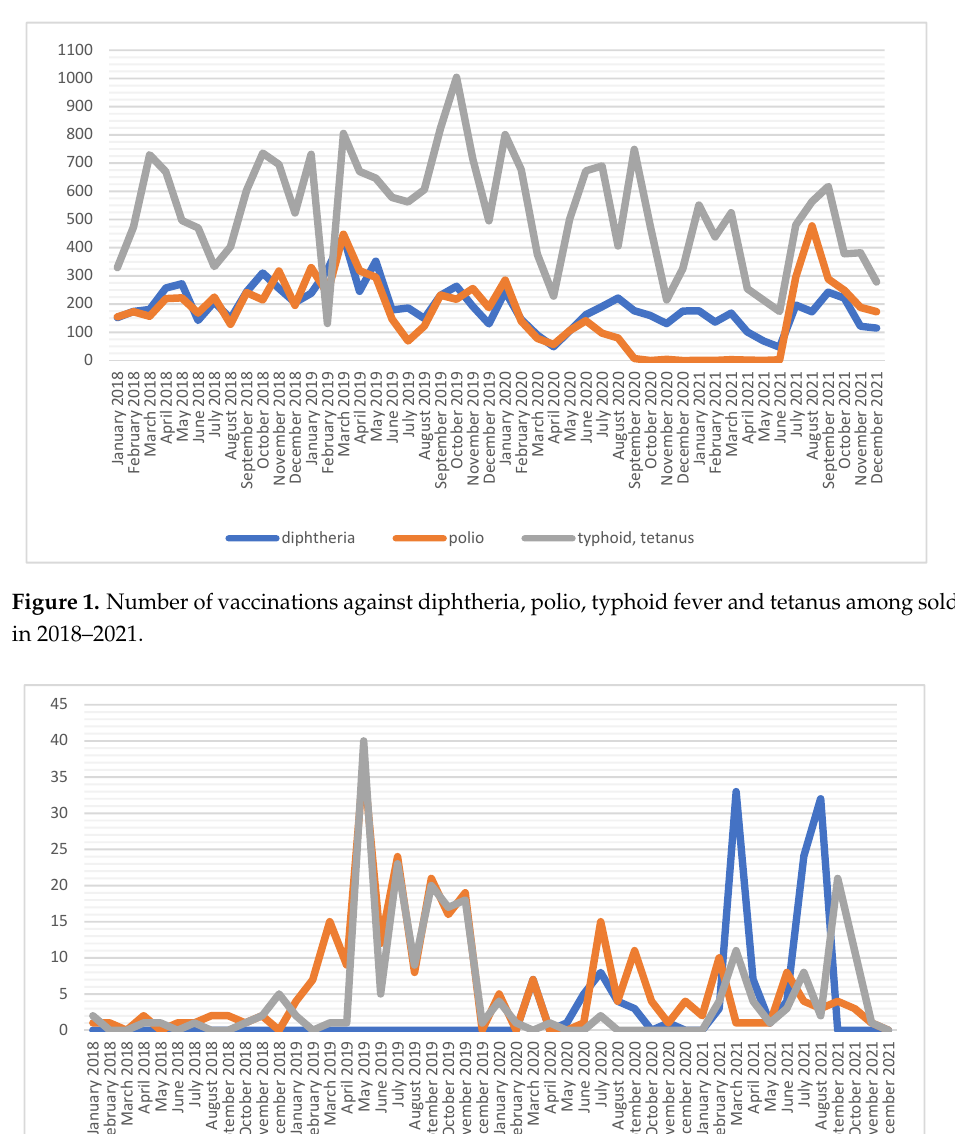
Figure 3. Number of vaccinations against measles, mumps, rubella and chickenpox among soldiers in 2018–2021. Soldiers serving abroad are vaccinated against rabies, tick-borne encephalitis (TBE) and meningococcal disease. The number of injections performed for the above-mentioned vaccinations varies; however, there is a noticeable similarity in the curve distribution (Fig- ure 4). The number of injections against tick-borne encephalitis was, on average, almost two times higher than those against rabies or meningococcal disease in 2018. The highest